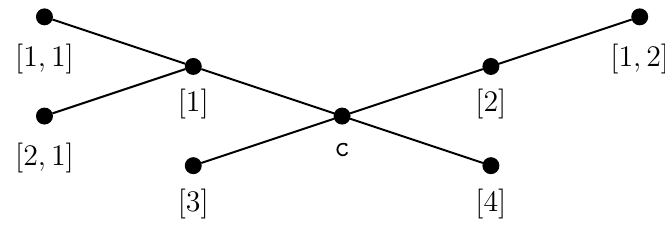
Figure 1: Labelling vertices in a T